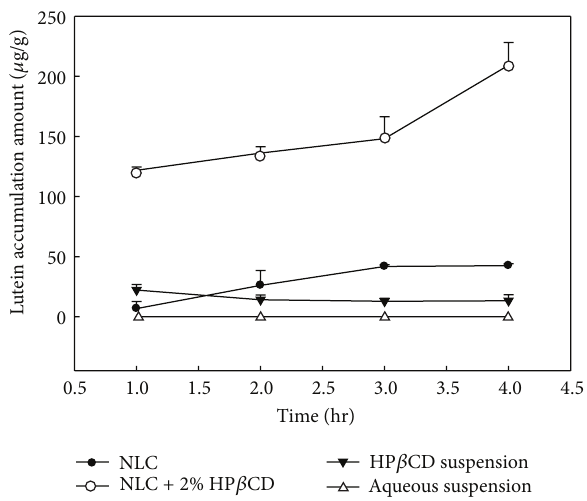
Figure 2: Effect of vehicles on lutein corneal accumulation. The lutein content in all vehicles is 2000 𝜇